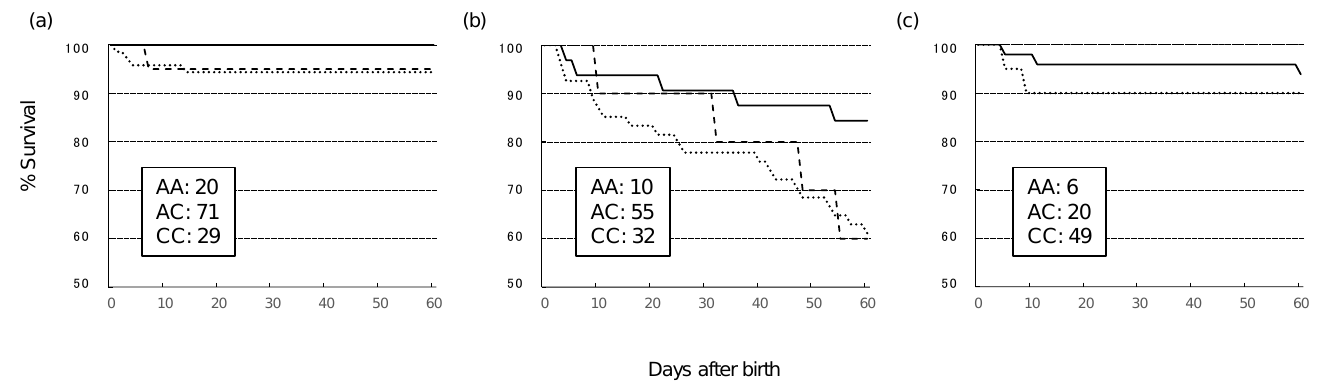
Figure 3. Survival curves of pigs before the invasion of PCV2b in 2008 ( a ), after invasion in 2010 ( b ), and after vaccination against PCV2 in 2012 ( c ). Survival rates of pig populations with AA, AC, and CC are indicated by dashed, dotted, and solid lines, respectively. The legend indicates the numbers of animals investigated with the respective genotypes.